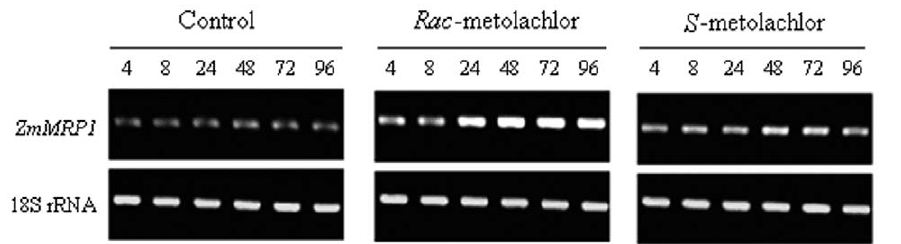
Figure 2. Semi-quantitative RT-PCR analysis of ZmMRP1 expression in maize leaves after treatment by rac - and S -metolachlor. The numbers (4, 8, 24, 48, 72 and 96) above each lane indicate the time intervals (h) after treatment. The experiment was repeated twice with similar results.